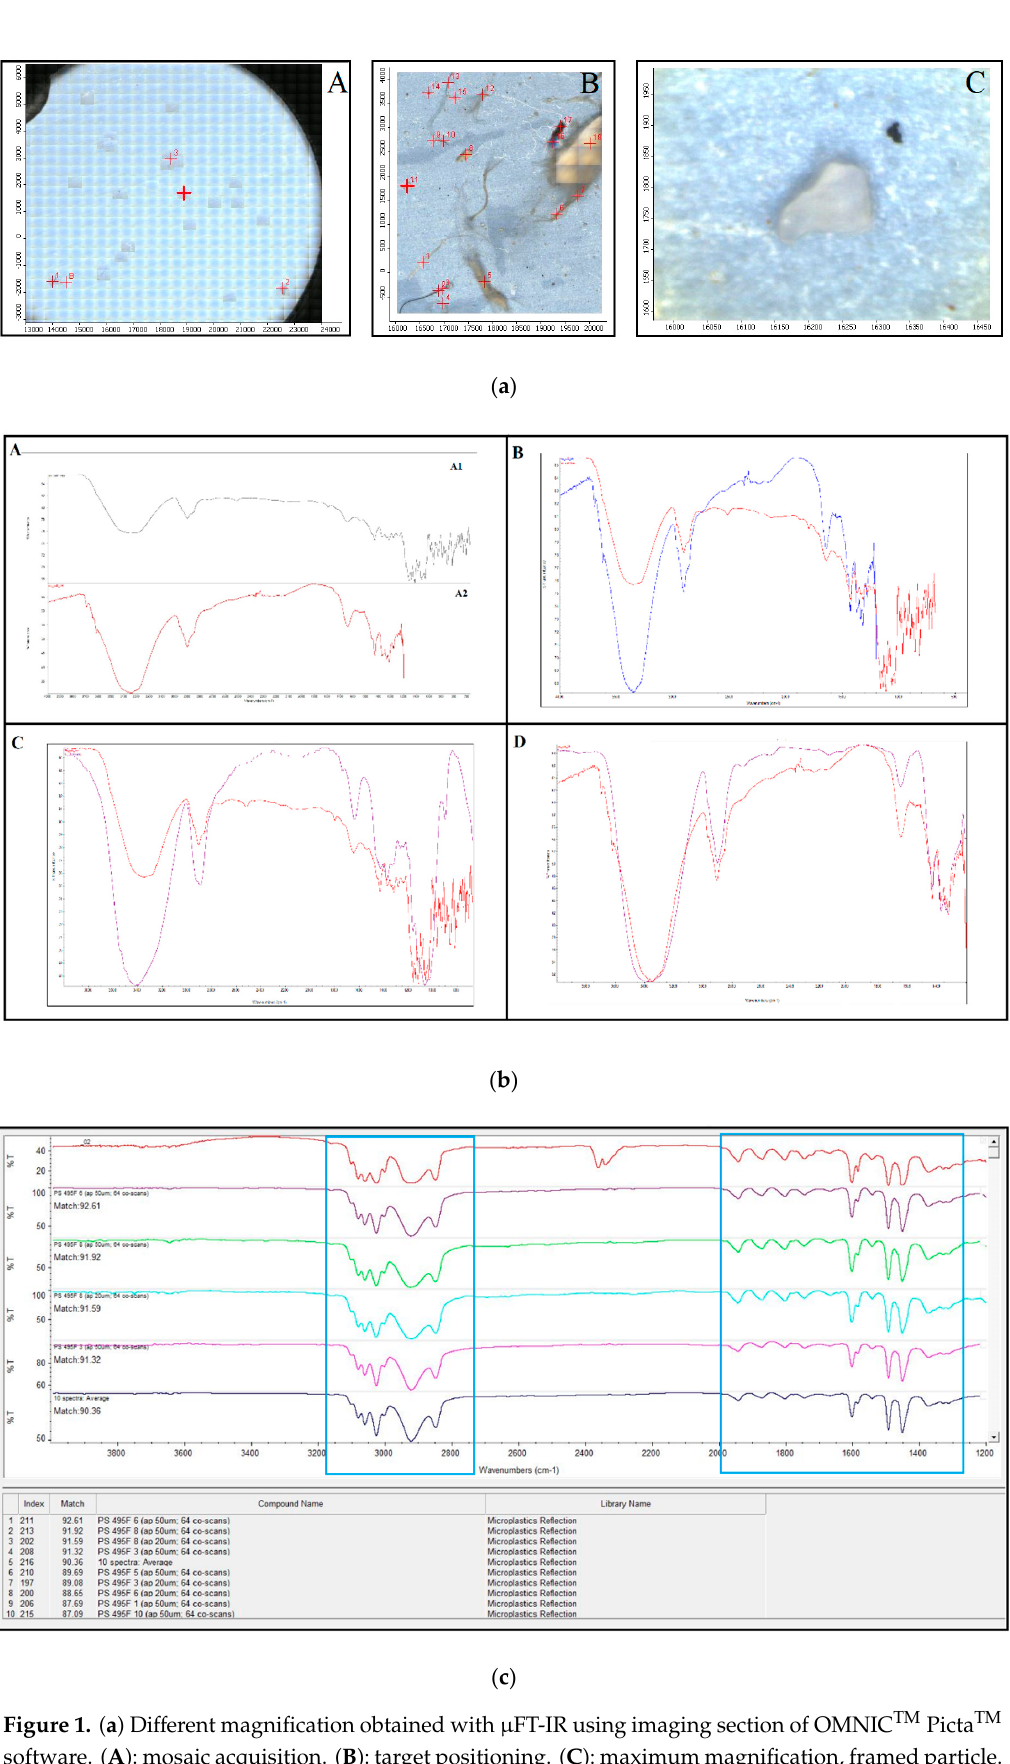
Figure 1. ( a ) Di ff erent magnification obtained with µ FT-IR using imaging section of OMNIC TM Picta TM software. ( A ): mosaic acquisition. ( B ): target positioning. ( C ): maximum magnification, framed